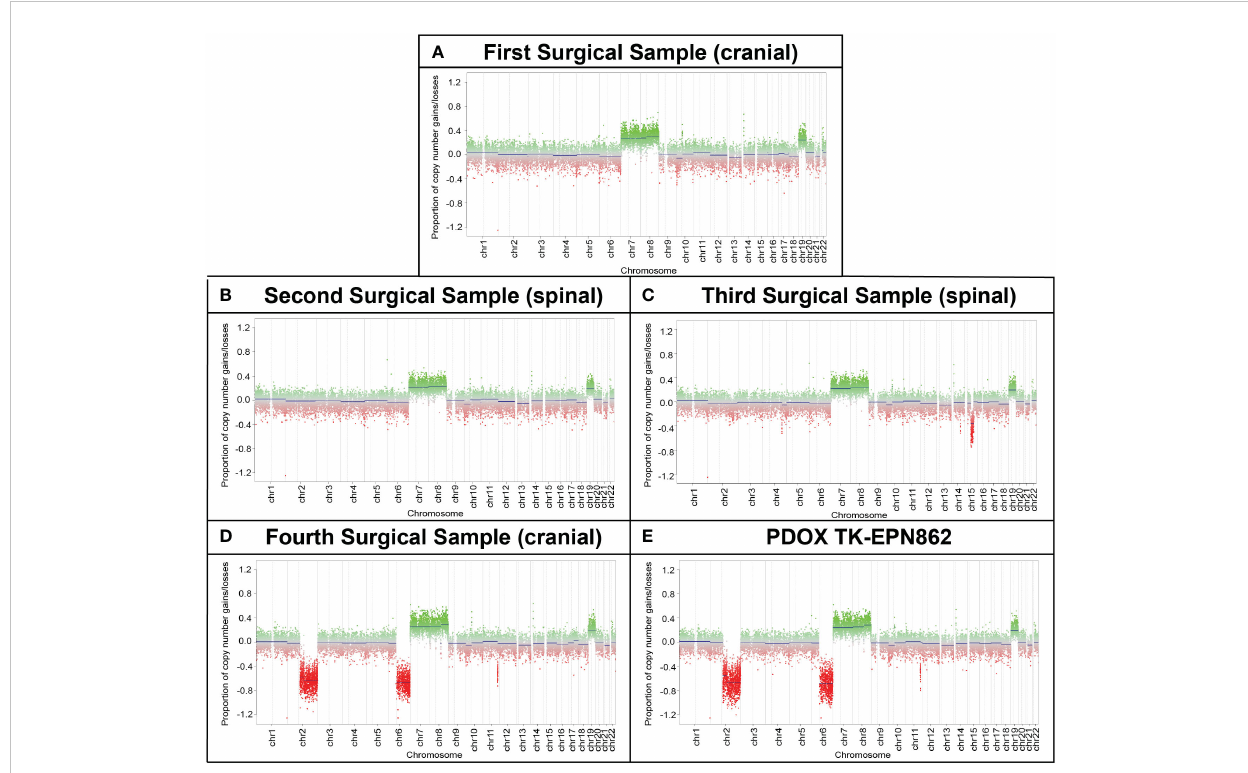
FIGURE 6 Longitudinal copy number analysis indicates the acquisition of additional genomic changes with disease progression. Copy number estimates (generated by MolecularNeuropathology.org using DNA methylation array data) for chromosomes 1 to 22 showing gains/ampli fi cations ( green ) or losses ( red ) for (A) the primary cranial tumor ( fi rst surgical sample) and (B, C) two spinal metastases (second and third surgical samples). (D) The cranial metastasis (fourth surgical sample) and (E) TK-EPN862 PDOX (derived from the fourth surgical sample), exhibited the same chromosomal gains as samples 1-3, with additional losses of chromosomes 2q and 6q